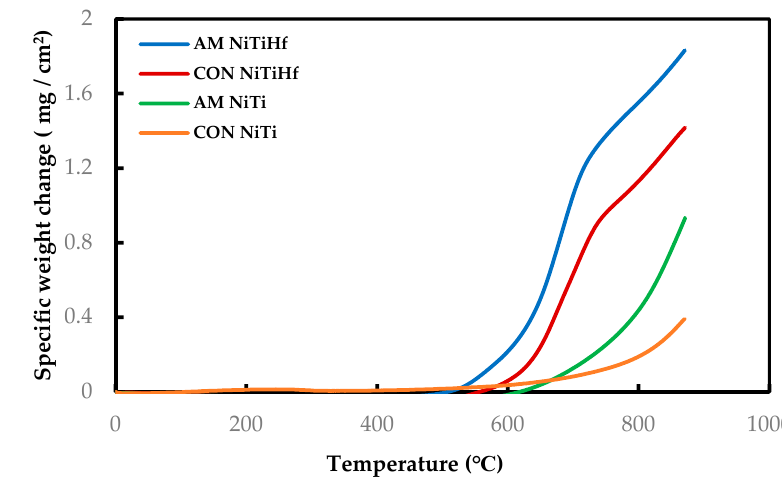
Figure 1. Dynamic thermogravimetric analysis (TGA) measurement of AM and CON NiTi and NiTiHf from 22 to 900 °C in air flow.